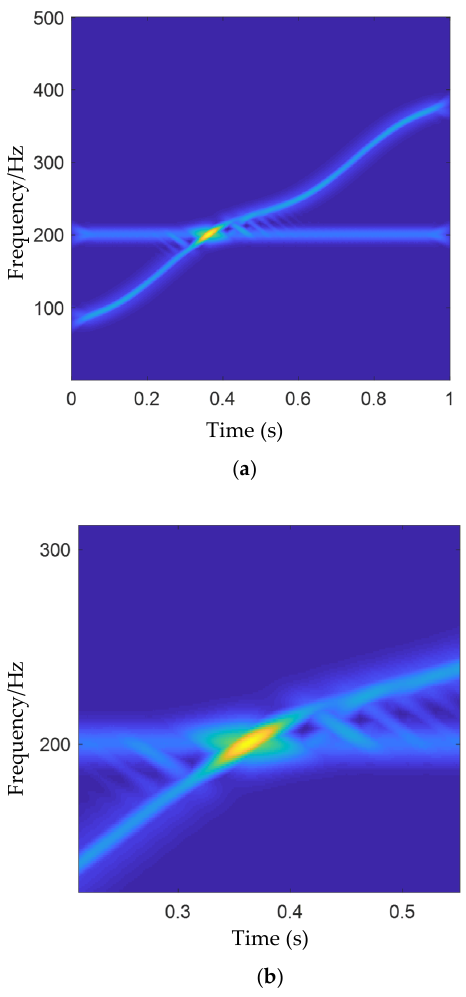
Figure 11. TF distribution of f ( t ) based on GLCT. ( a ) TF distribution ( b ) Local enlarged figure